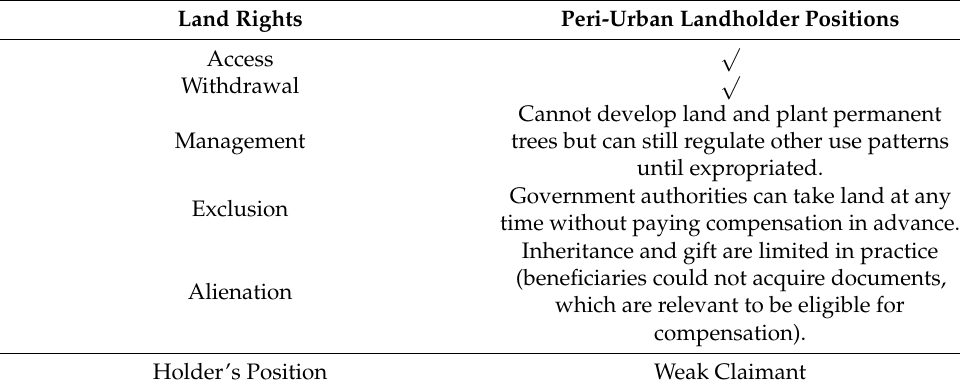
Table 3. Bole-Arabsa and Cheri site peri-urban landholder